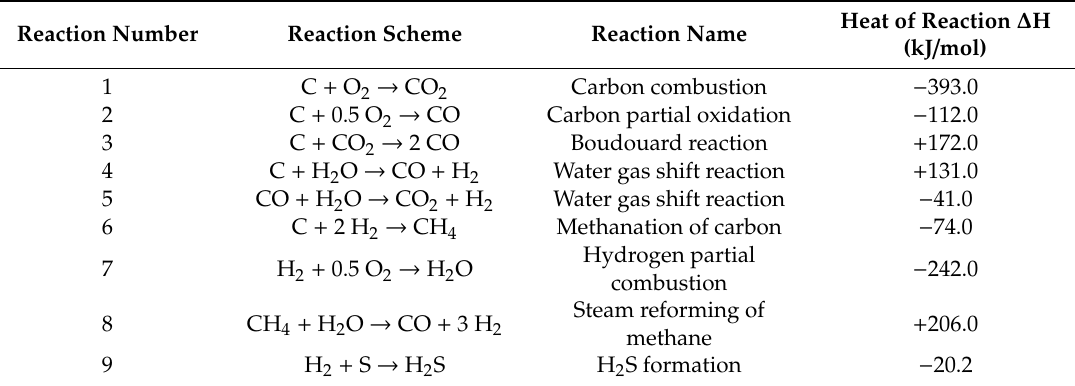
Figure 5. Aspen Plus ® flowsheet of biomass gasification model. Table 4. Restricted chemical equilibrium in the GASI